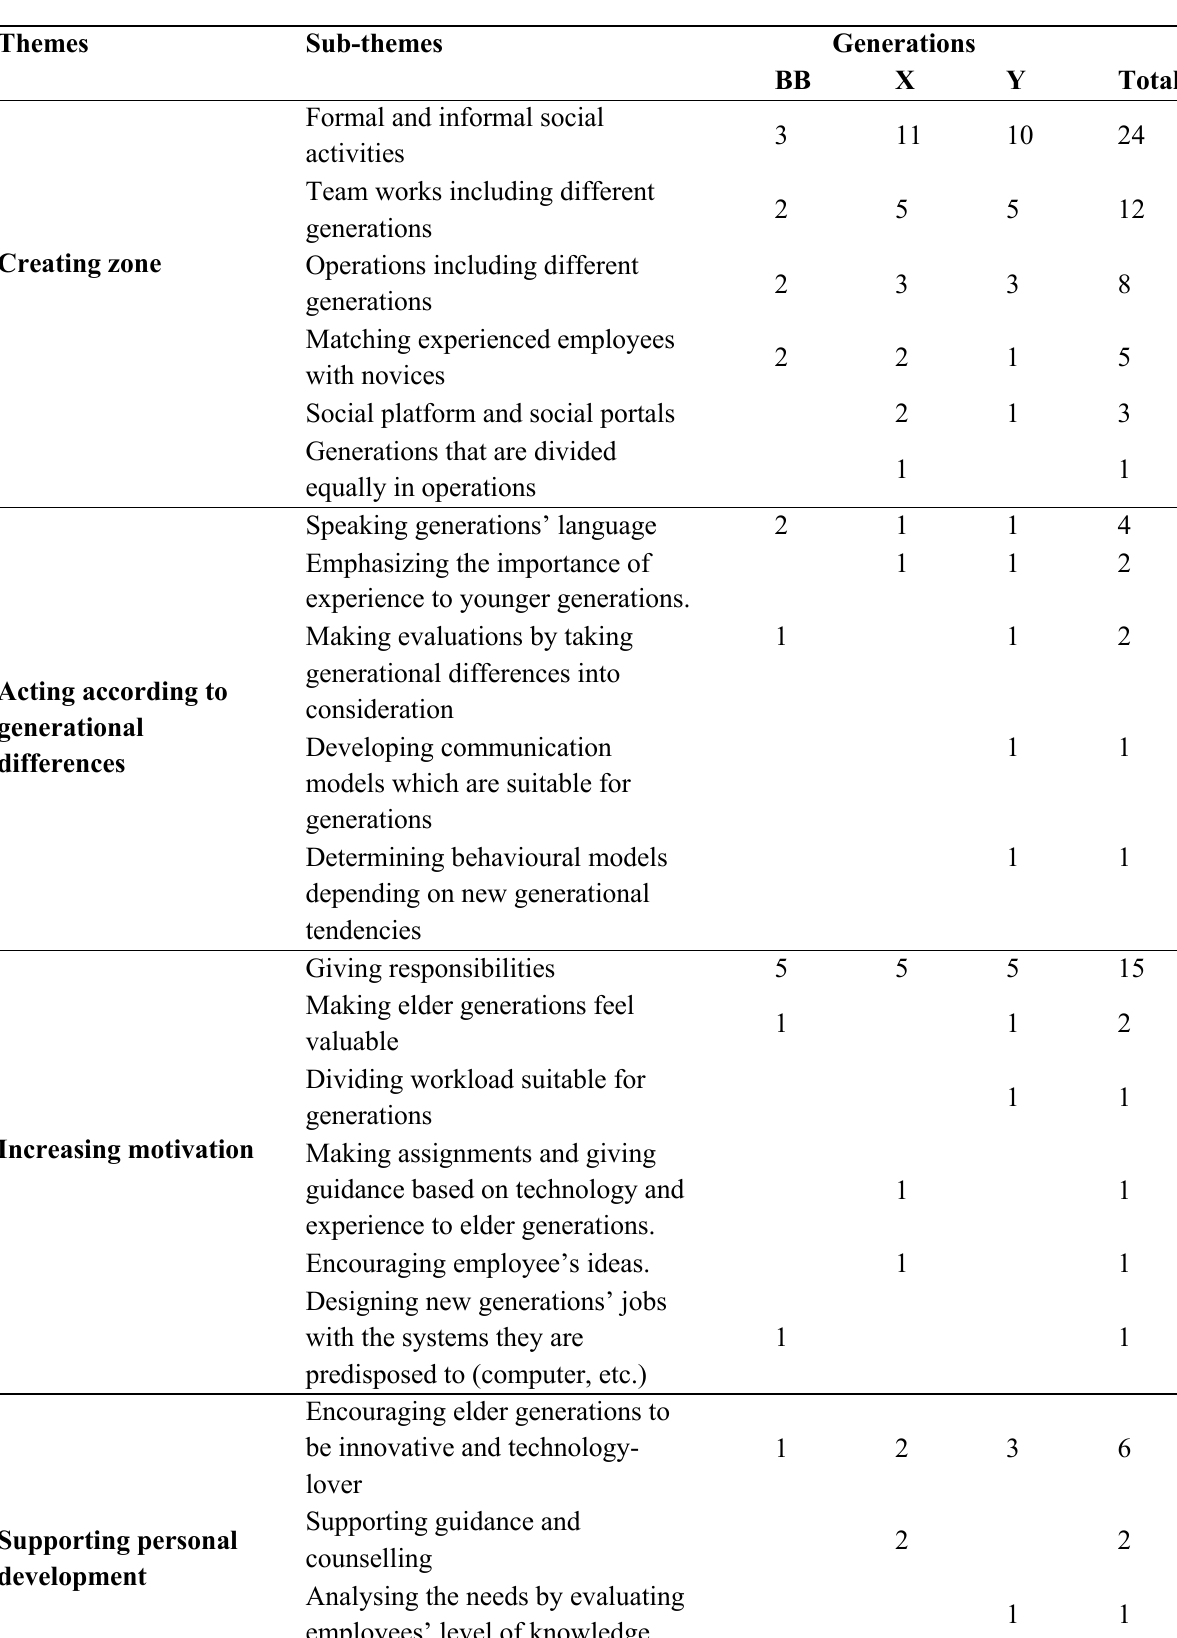
Table 1: Main themes and sub-themes